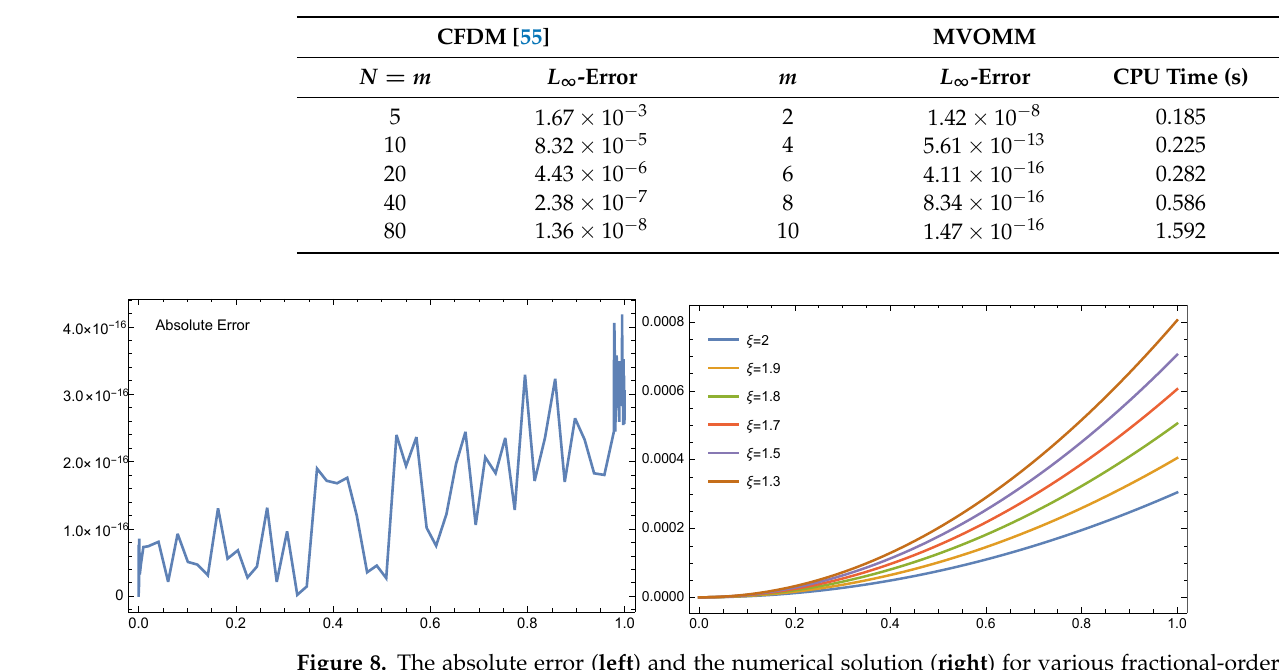
Table 8. Comparison of the highest absolute errors for Example 5 using ξ = 2 and various values of m from [55] and our proposed approach.